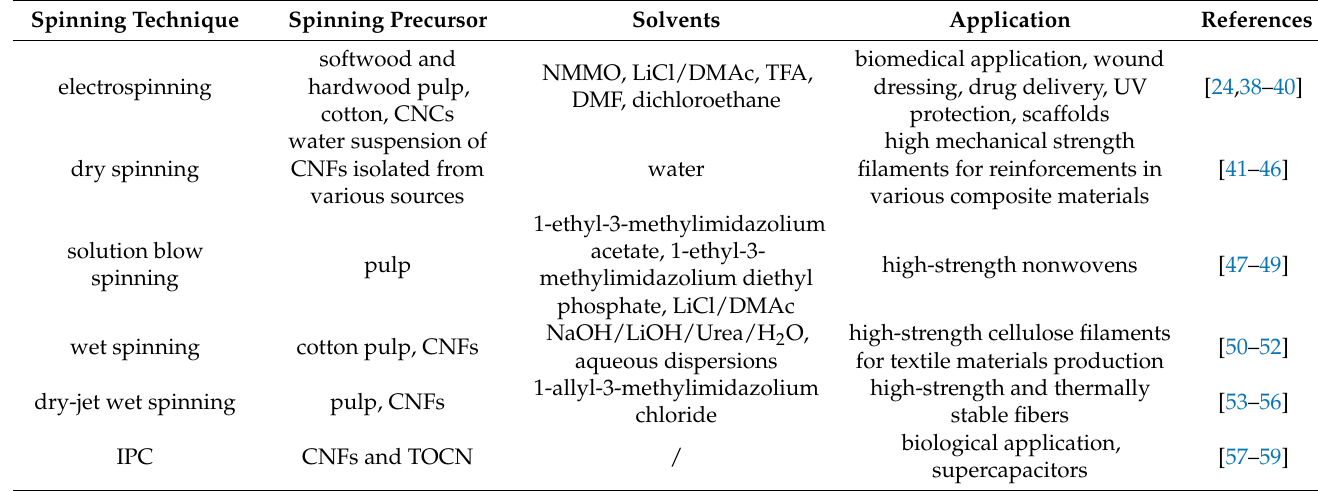
Table 2. Overview of the most utilized spinning techniques for cellulose nanofiber preparation, most common precursors and solvents used, and application of produced